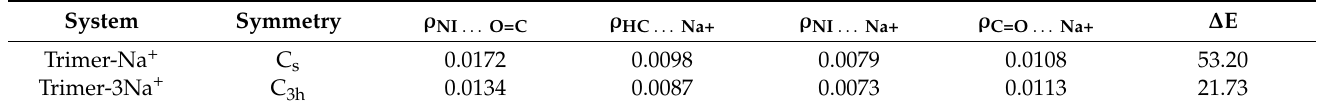
Table 6. Complexation energy, ∆ E (kcal/mol), and electron density at bond critical points, ρ (a.u), for Na + binding by the cyclic trimer of the model system, ((HOOC) 2 -C 6 H 2 -(NHI) 2 ).